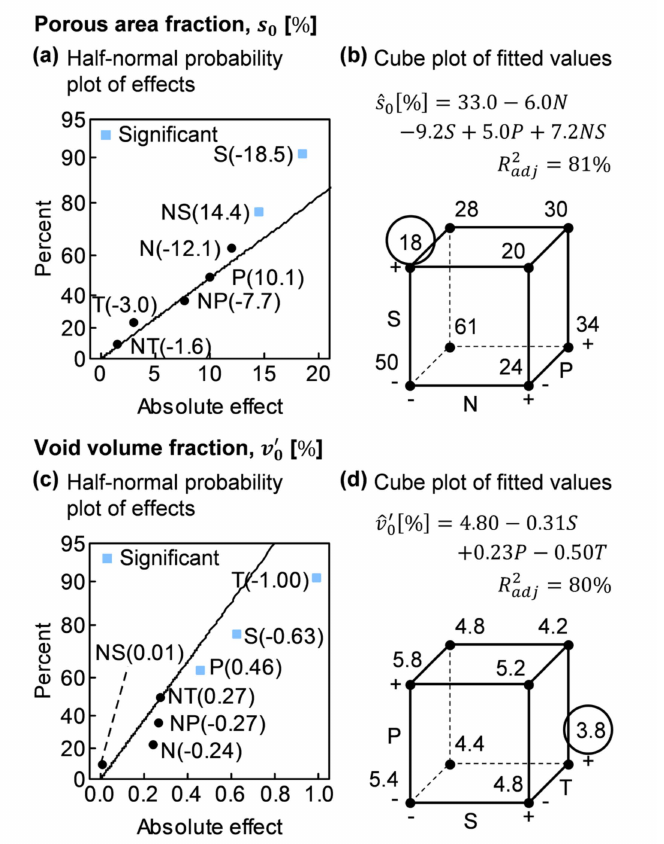
Figure 16. ANOVA supporting plots: ( a ) Porous area fraction, s 0 , half-normal probability plot of effects; ( b ) s 0 cube plot of fitted values; ( c ) Void volume fraction, v (cid:48) effects; ( d ) v (cid:48) cube plot of fitted 0